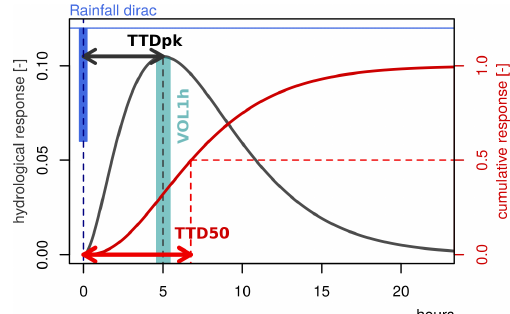
Figure 6. Illustration of the TTD properties on a unit hydrograph: TTD50, TTDpk, and